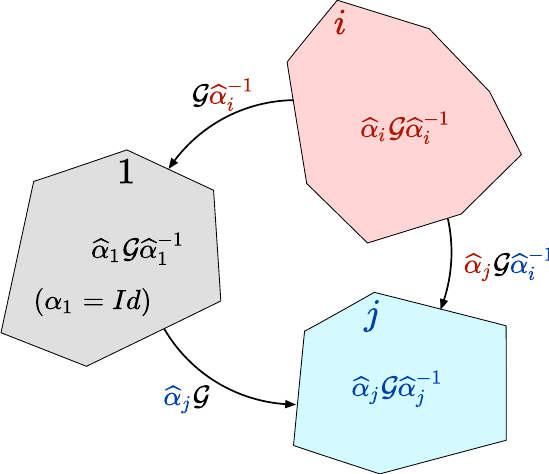
Figure 5. Transforming variant i into j in a N -crystal is achieved by transforming i back into